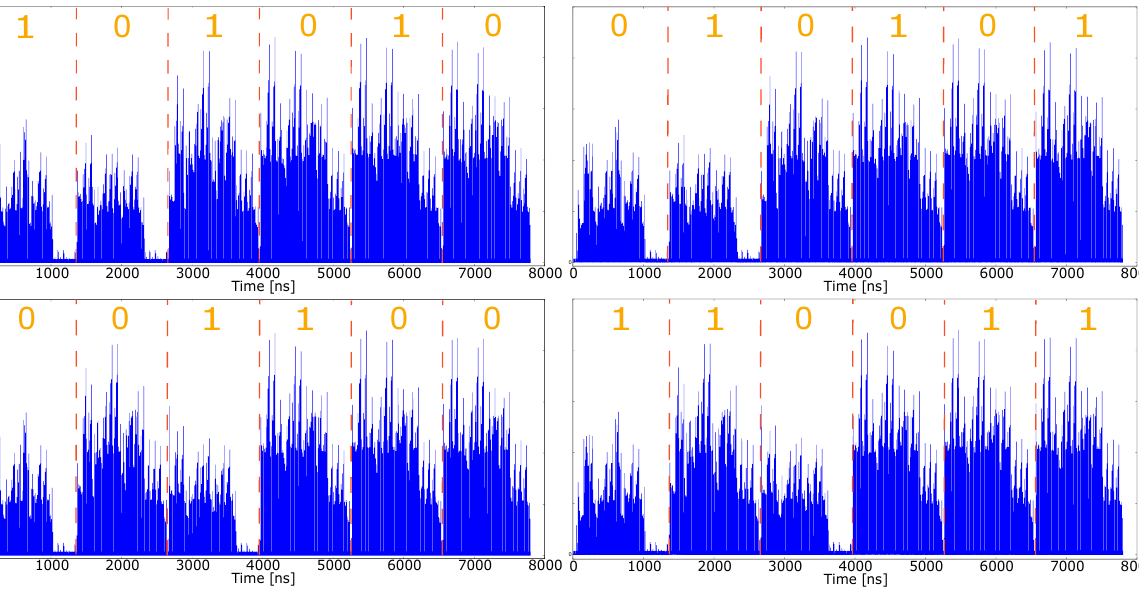
Figure 8. Acquired Power Traces for the Double-and-Add-Always (Algorithm 2) where the least significant part of the key k is (LSB first): -101010 ( top left ), -010101 ( top right ), -001100 ( bottom left ), -110011 ( bottom right